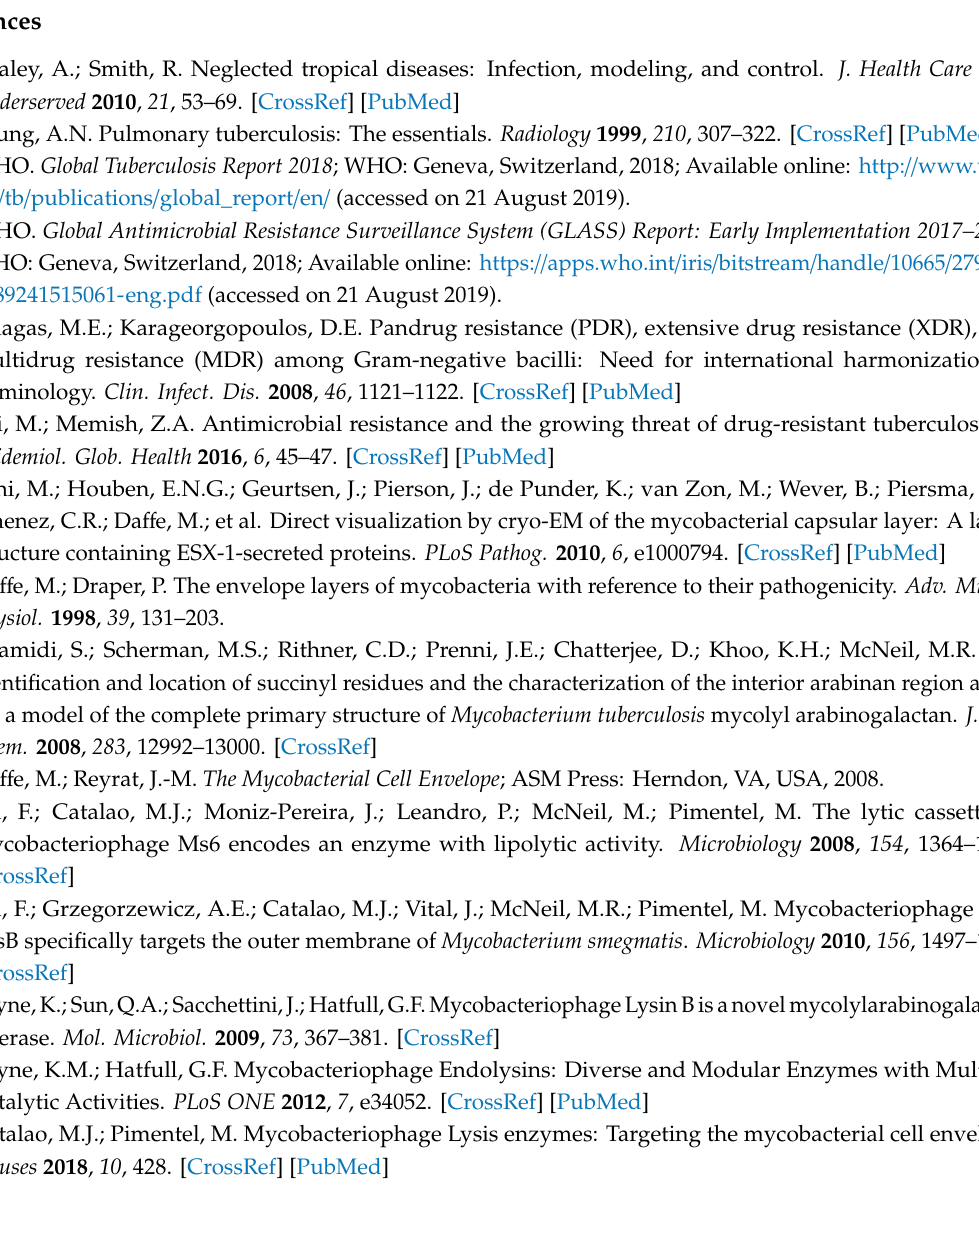
Types of active site conformations of LysB models and the best docking score upon docking of p -NP ligands, Table S4: Quantitative measurements and structural alignments of LysB active sites to their counterparts of the α / β hydrolases, Table S5: Specific activities and kinetic properties of LysB enzymes in comparison to relative cutinases and